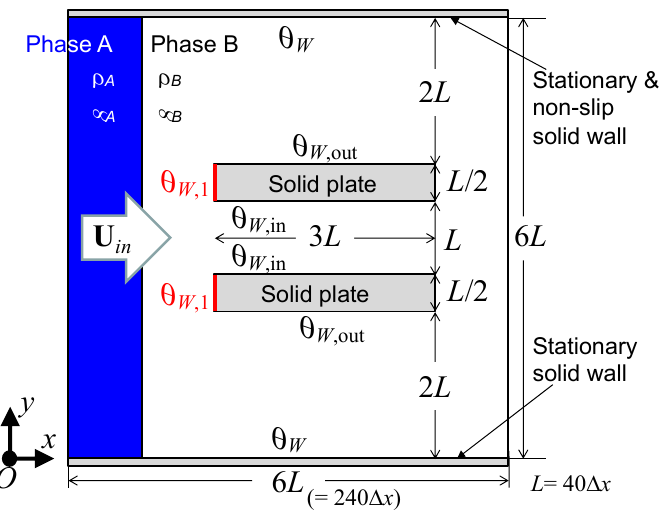
Figure 1. Illustration of the capillary tube model.